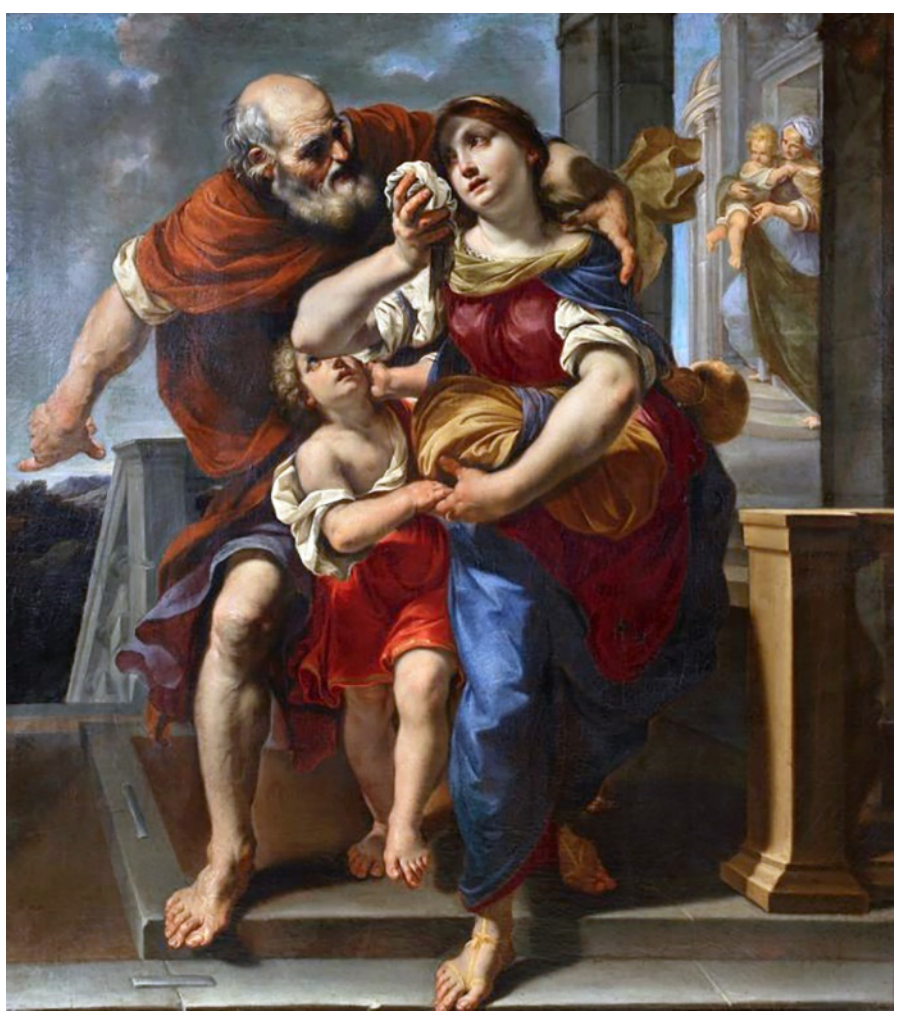
Figure 17. Cristoforo Savolini, ca 1670. Moscow, Pushkin Museum, inv. 2662.